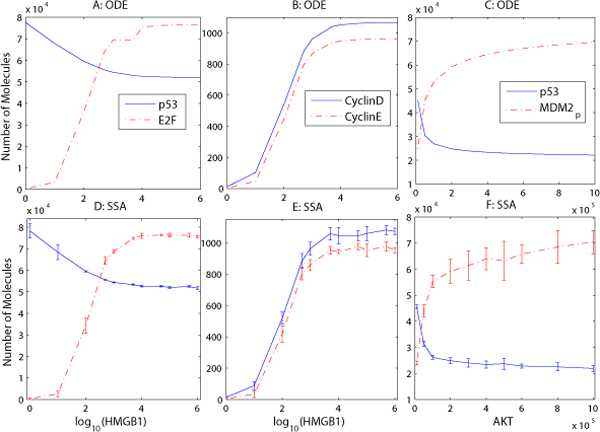
HMGB1 and AKT sensitivity study. Overexpression of HMGB1 (A-B, D-E) leads to the increase of oncoprotein E2F and DNA replication proteins CyclinD/E, and to the decrease of p53. Overexpression of AKT (C, F) activated by HMGB1 increases the expression level of MDM2p and represses p53, using ODE (A-C) and SSA (D-F) simulations.